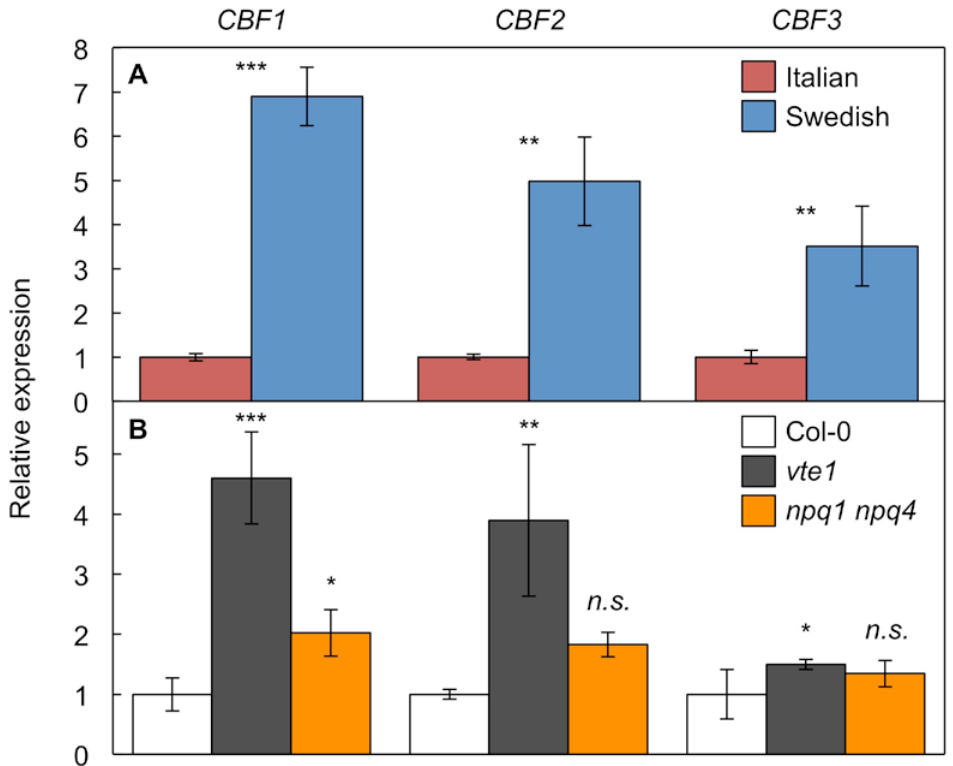
Figure 5. Relative expression of CBF1 , CBF2 , and CBF3 genes from the leaves of ( A ) Italian (red columns; mean transcript level set to 1) and Swedish (blue columns) ecotypes and ( B ) wild-type Col-0 (open columns; mean transcript levels set to 1) and the vte1 (dark gray columns) and npq1 npq4 (orange columns) mutants of Arabidopsis thaliana grown at 35 °C. Mean values ± standard deviations ( n = 3 or 4); significant differences (Student’s t -test) between ( A ) ecotypes or ( B ) mutants and wild-type, respectively, indicated by asterisks; * = p < 0.05, ** = p < 0.01, *** = p < 0.001, n.s. = not significantly different.